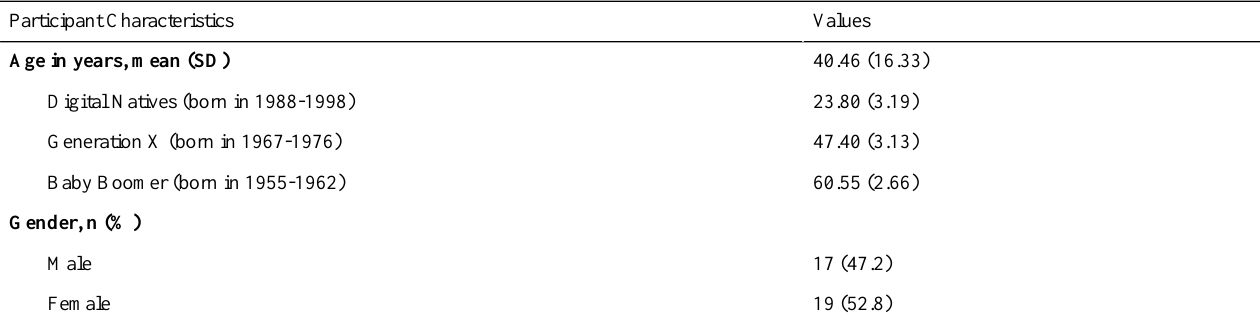
Table 1. Baseline characteristics of the participants (N=36).